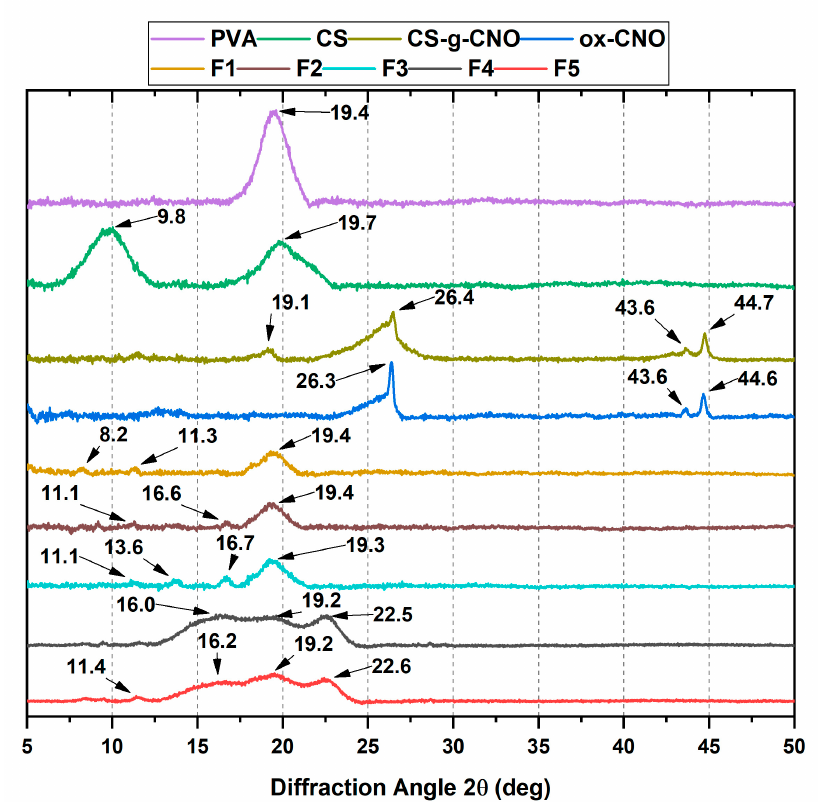
Figure 7. X-ray di ff raction (XRD) of the di ff erent nanocomposite films. Formulations: F1 (CS: Figure 7. X-ray diffraction (XRD) of the different nanocomposite films. Formulations: F1 (CS: PVA:ox- PVA:ox-CNO30.00:70.00:0); F2(CS:PVA:ox-CNO29.50:70.00:0.50); F3(CS:PVA:ox-CNO29.00:70.00:1.00); CNO 30.00:70.00:0); F2 (CS:PVA:ox-CNO 29.50:70.00:0.50); F3 (CS:PVA:ox-CNO 29.00:70.00:1.00); F4 F4 (CS:PVA:CS-g-CNO 29.50:70.00:0.50); and F5 (CS:PVA:CS-g-CNO (CS:PVA:CS-g-CNO 29.50:70.00:0.50); and F5 (CS:PVA:CS-g-CNO 29.00:70.00:1.00).